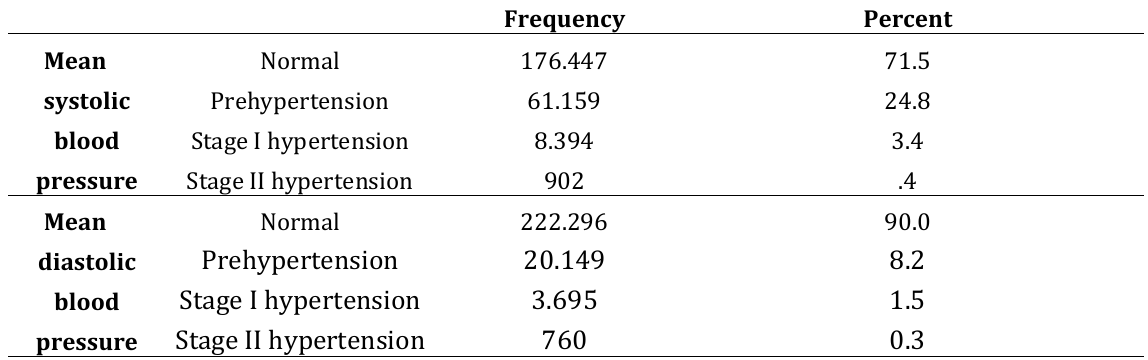
Table 2: Measured systolic and diastolic blood pressure status of the study group based on a classification made by the Seventh Report of the Joint National Committee on Prevention, Detection, and